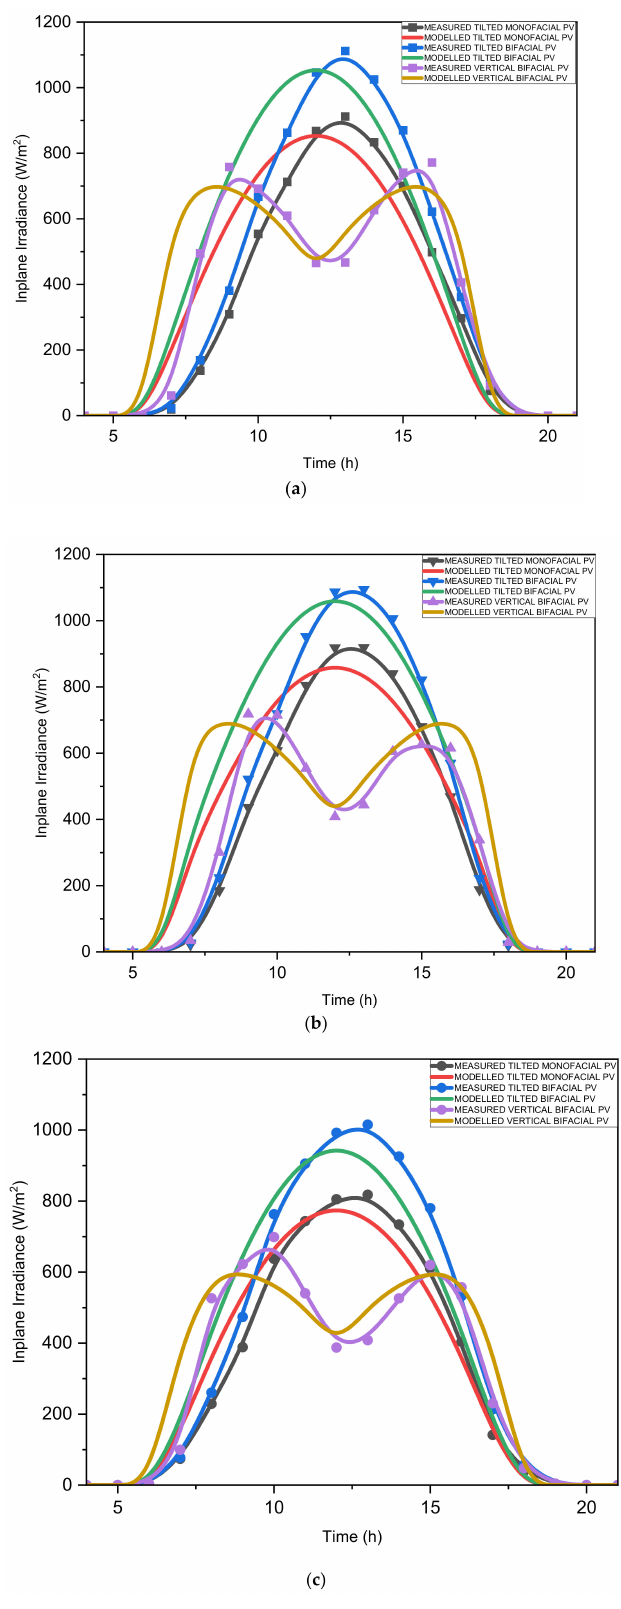
Figure 2. ( a ) Single-day analysis of in-plane radiation of the various solar PV; 21 March; ( b ) single-day analysis of in-plane radiation of the various solar PV; 21 June; ( c ) single-day analysis of in-plane radiation of the various solar PV; 21